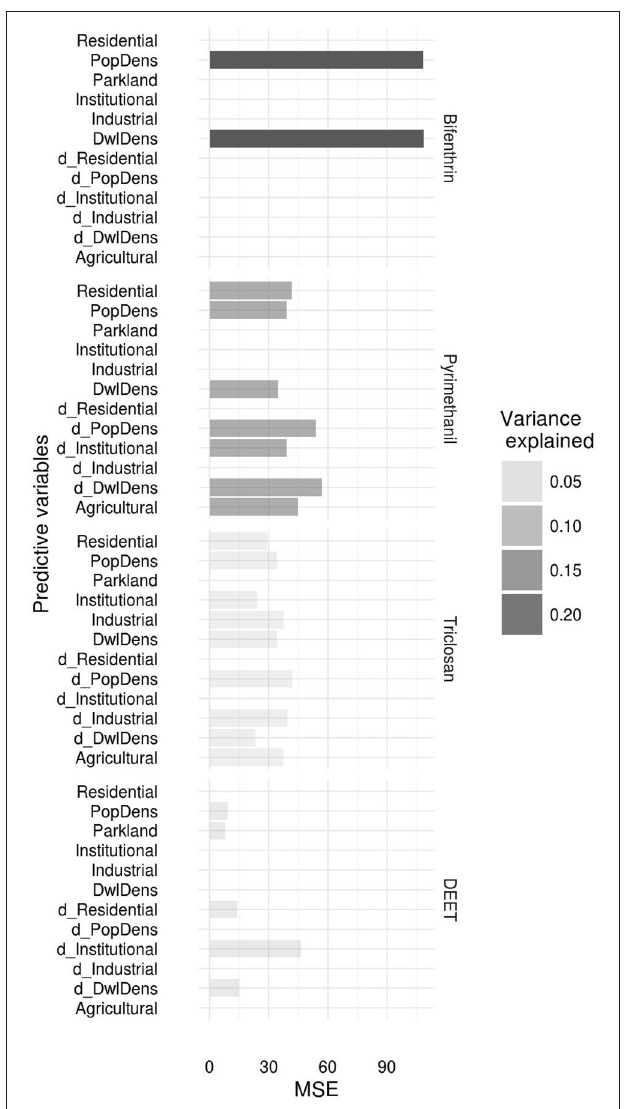
FIGURE 3 | Summary of selected predictor variables for frequently detected contaminants and comparison of their relative influence in each model. The relative influence of each land use category is indicated on the x-axis, scaled to a percentage of the total for each model. Where a land use variable does not appear in a model, this indicates it did not contribute significantly to that model. Bars are shaded in proportion to relative goodness of fit for each